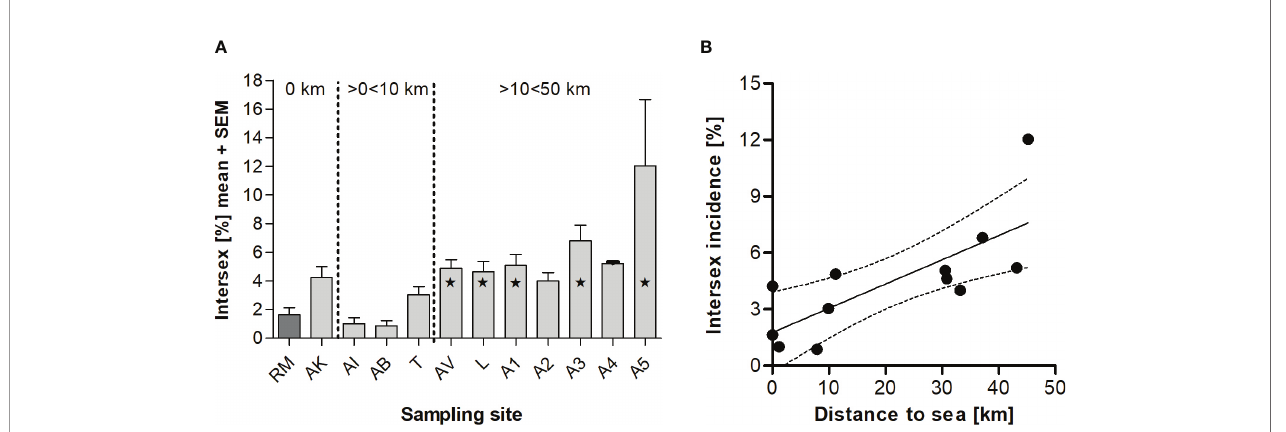
FIGURE 2 | Mean intersex incidence (+ SEM) in Echinogammarus marinus at different sampling sites in NW-Brittany (France) during long-term-monitoring from 2012 to 2020 (A) . Total numbers of intersex specimens: n(RM)=19, n(AI)=14, n(AK)=52, n(AB)=9, n(T)=36, n(AV)=56, n(L)=51, n(A1)=64, n(A2)=13, n(A3)=71, n(A4)=16, n (A5)=24. Statistically signi fi cant differences to reference RM are marked by asterisks (* = p < 0.05, one-way ANOVA with Dunnett ’ s Multiple Comparison-Test). Linear regression between the mean intersex relative incidence (2012 – 2020) in Echinogammarus marinus and the distance to the sea (p < 0.01, Pearson r = 0.749) (B)